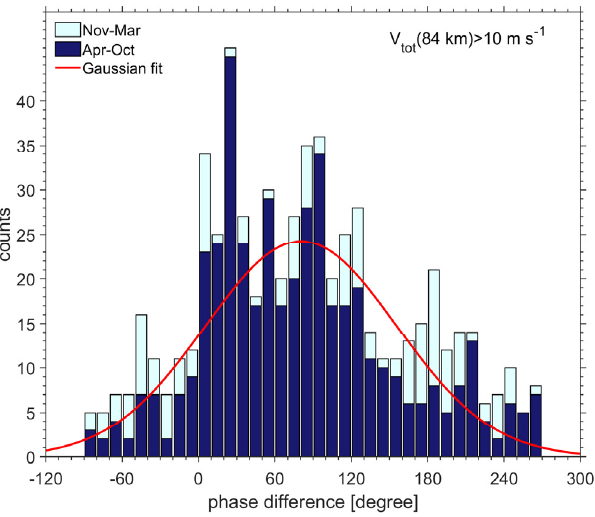
Figure 7. The same as Figure 6 but for the phase difference. The red line indicates the Gaussian fit.